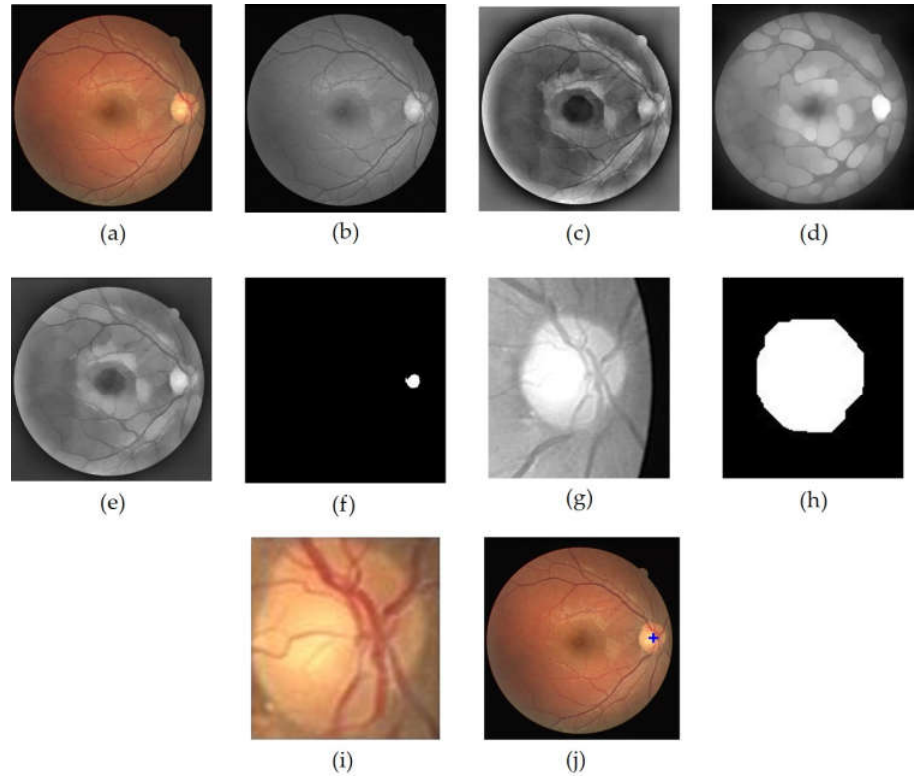
Figure 3. OD localization process, ( a ) input image, ( b ) grayscale image of I ( c ) I pre 1 image, ( d ) I pre 2 image, ( e ) I c , ( f ) OD center area candidate ( g ) OD ROI ( h ) closing+opening result of binary OD ROI, ( i ) OD, ( j ) localization result of OD